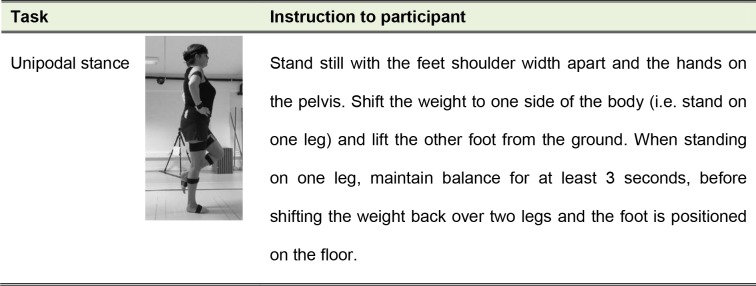
Detailed description of the instructions to the participants.